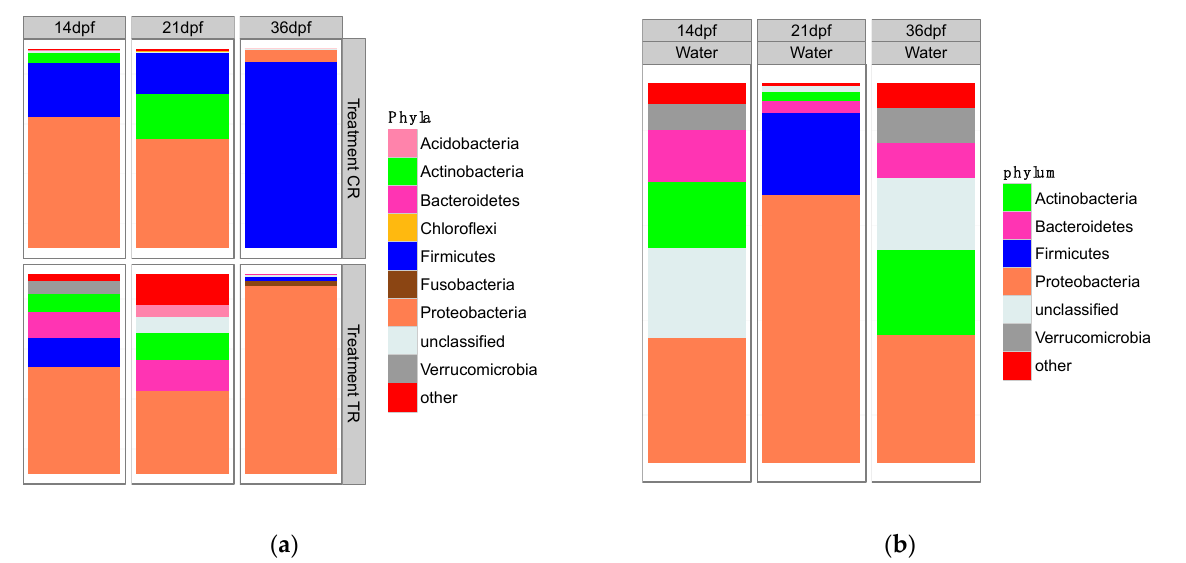
Figure 4. ( a ) Relative abundance (%) of six most abundant bacterial phyla ( Acidobacteria , Actinobacteria , Bacteroidetes , Firmicutes , Fusobacteria , and Proteobacteria ) found in the larval lake sturgeon GI tract for each treatment at different sampling times. The remaining taxa were assigned as others. ( b ) Relative abundance (%) of six most abundant bacterial phyla ( Acidobacteria , Actinobacteria , Bacteroidetes , Firmicutes , Proteobacteria , and Verrucomicrobia ) found in aquatic samples. The remaining taxa were assigned as others.